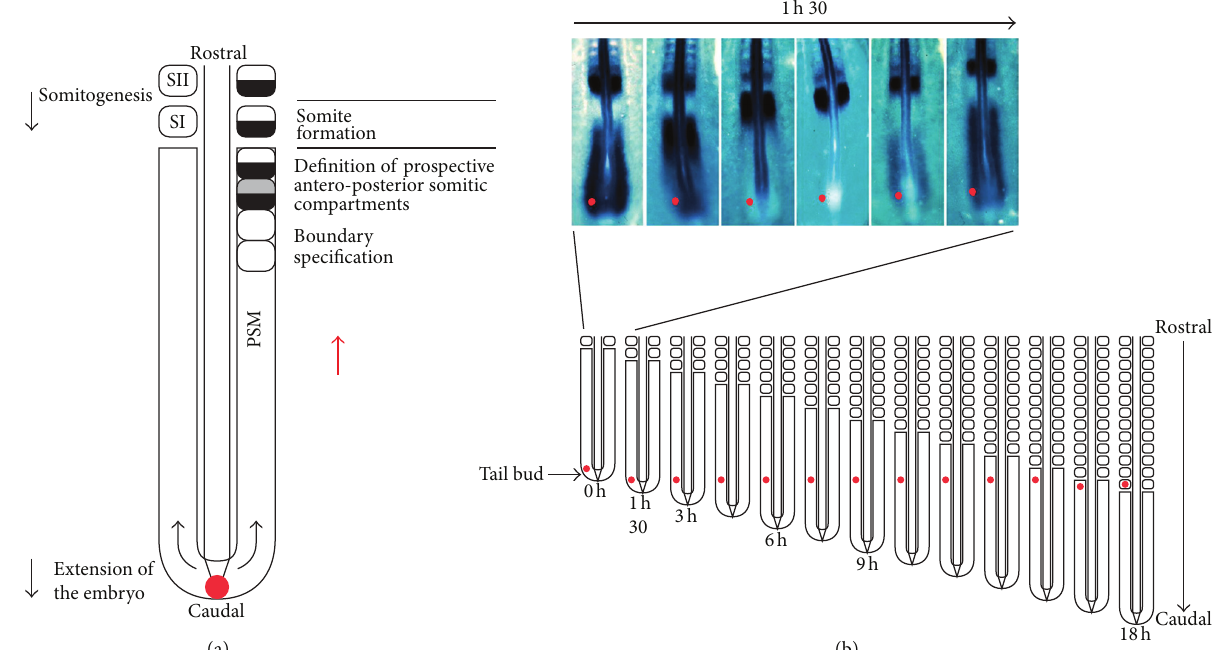
F 4: Illustration of somite formation from the presomitic mesoderm (PSM) in the chick embryo. Paired somites are formed every 90 minutes in a periodic fashion every 90 minutes shown in (a). (b) A molecular clocked linked to segmentation by dynamic and periodic expression of the cyclic genes in the PSM. Top: Lunatic Fringe mRNA expression appears as a wave sweeping across the whole PSM once during each somite formation as illustrated by in situ hybridization in this 17-somite-old chick embryo. During each somite formations, PSM cells illustrated by the dot undergo a phase of upregulation of the cycling genes followed by a phase of down regulation of these genes. Bottom: As shown in this schematic representation of the progression of somitogenesis in the embryo, the cycles of expression of the cyclic genes will last while the cells remain in the PSM, which corresponds approximately to the time to form 12 somites in the chick embryo. ese PSM cells undergo 12 oscillations of the expression of the cycling genes. Reproduced with permission Expert Opinion in [9]. Reproduced from Expert Opinion in Expert Opin. Med. Diagn. (2008) 2(10):1107-1121 with permission of Informa UK